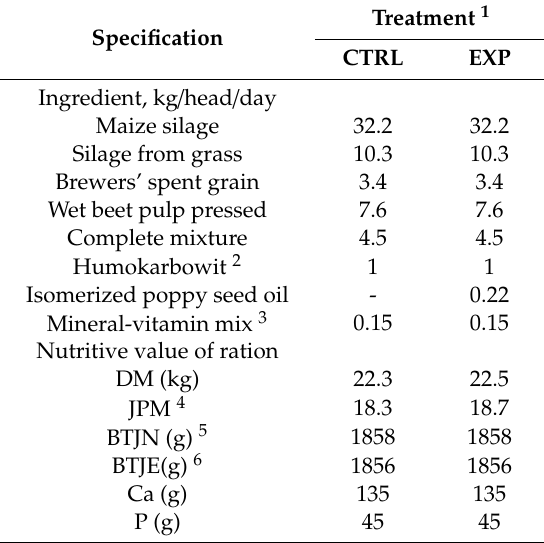
Table 2. Ingredients and nutritive value of cow